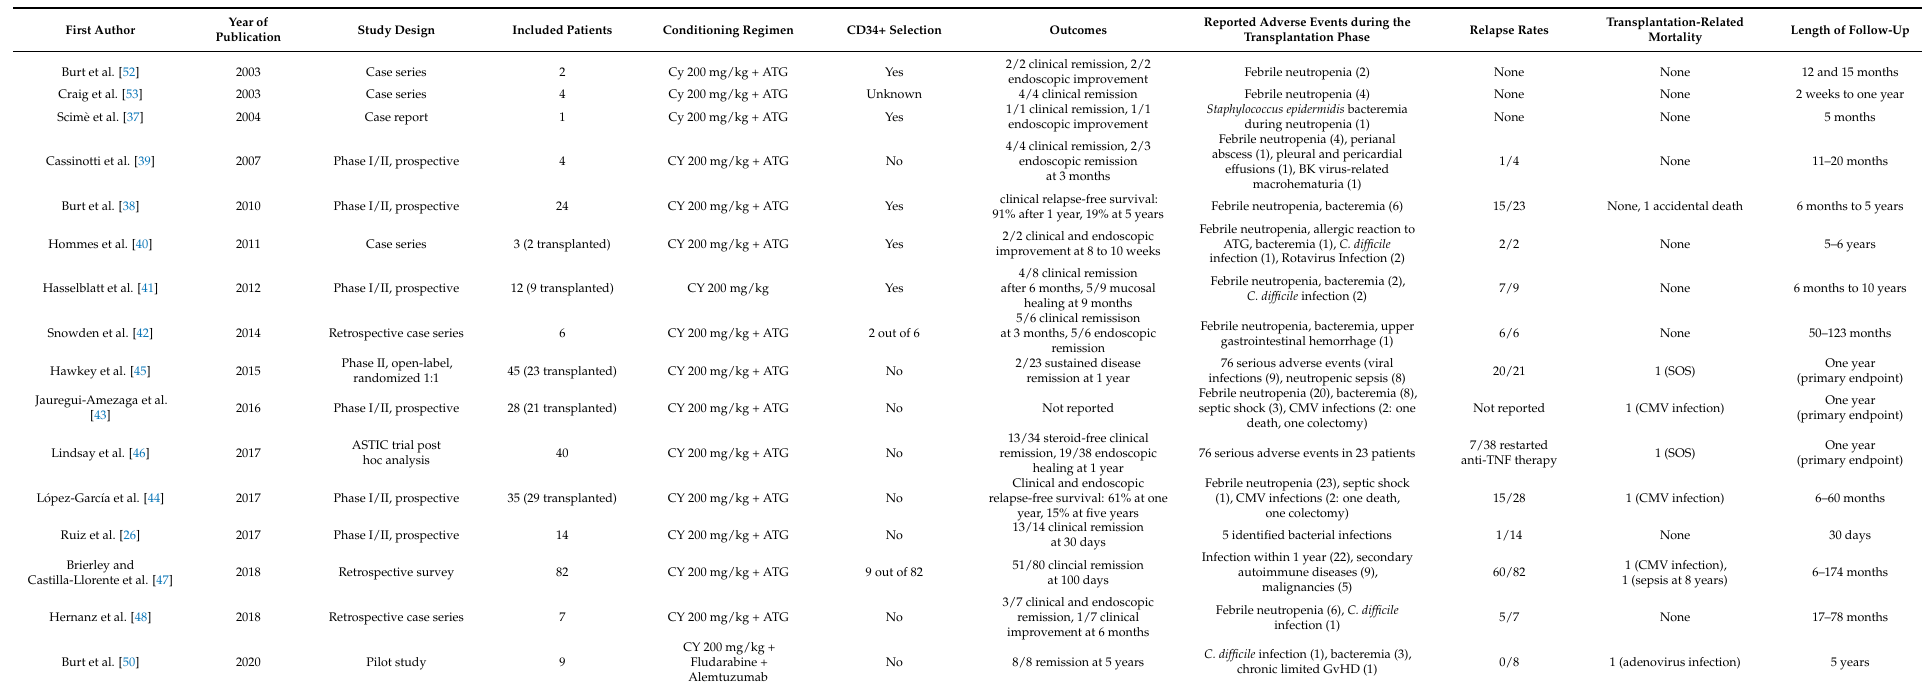
Table 1. Summary of available evidence for hematopoietic stem cell transplantation in Crohn’s disease. Except for Burt et al., 2020 (allogenic, non-myeloablative hematopoietic stem cell transplantation), all reported studies investigated autologous hematopoietic stem cell transplantation. Included patients in the reported studies are mainly adults, although Burt et al., 2003, Burt et al., 2010, Jauregui-Amezaga et al., 2016, L ó pez-Garc í a et al., 2017, and Hernanz et al., 2018 also included adolescents with a minimum age of 15 years. The study populations between the different reported trials may overlap in certain